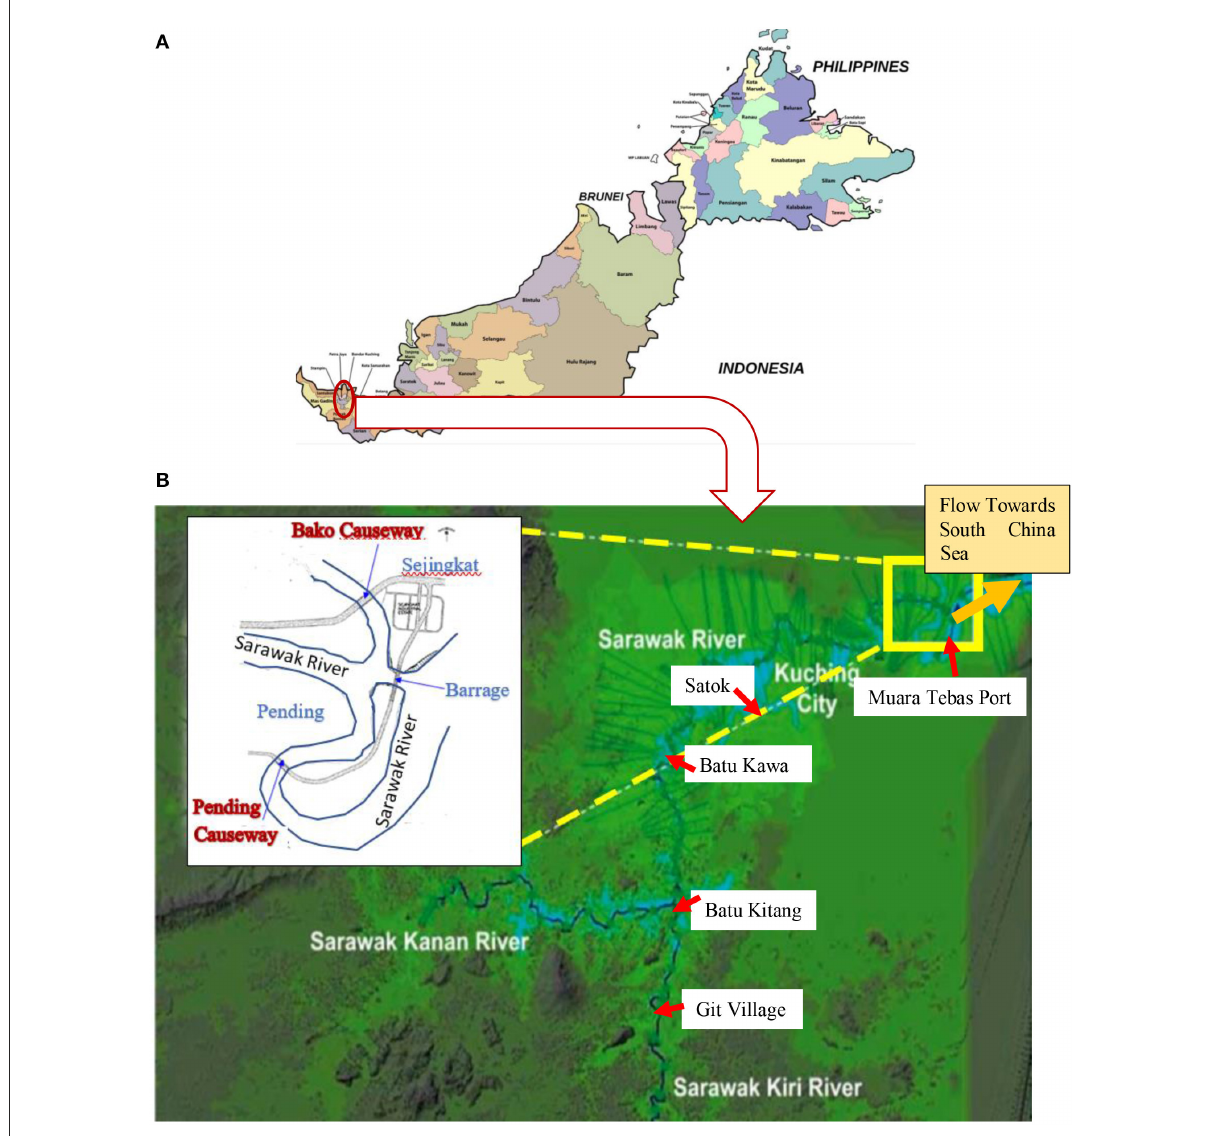
FIGURE1 River system of the Sarawak River basin. (A) Locality map of Sarawak River basin. (B) Locality of rainfall and water level stations (Kuok et al.,